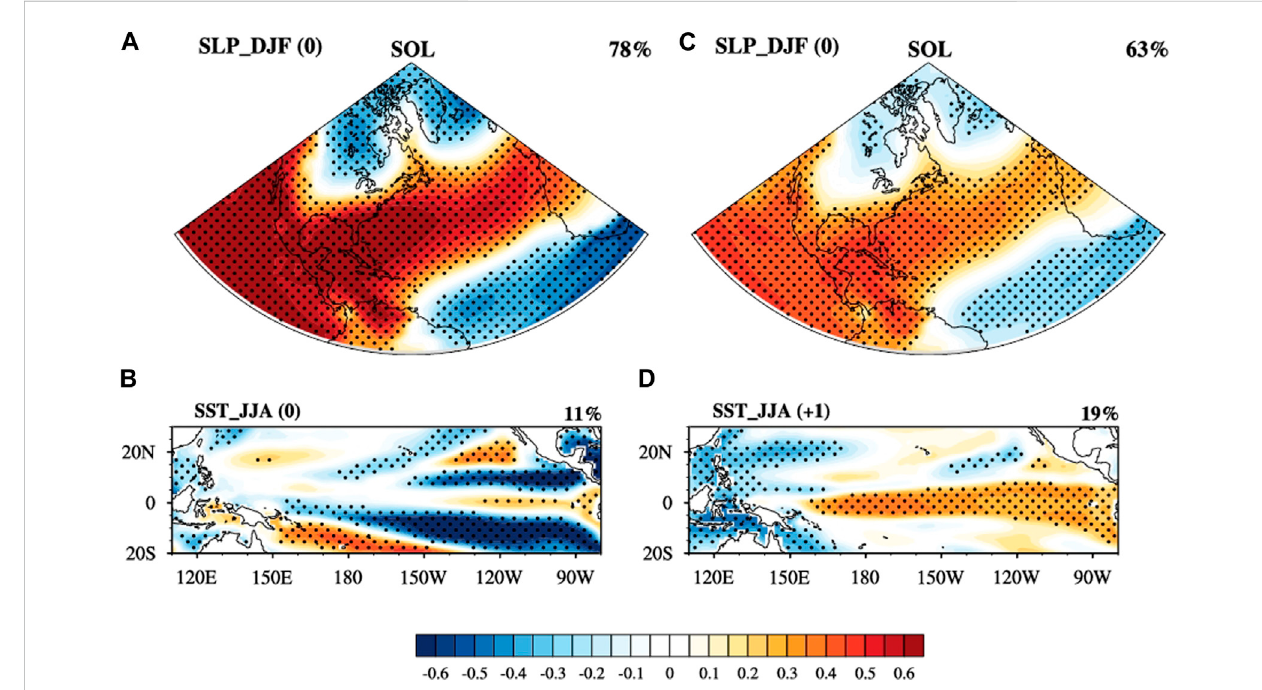
Figure 5A (color shading contours), in Dec – May (0) of the HS, a triple pattern of SST anomalies appears in the North Atlantic with negative SST anomalies in the north tropical Atlantic and the Labrador See, and a warm anomaly in the middle West